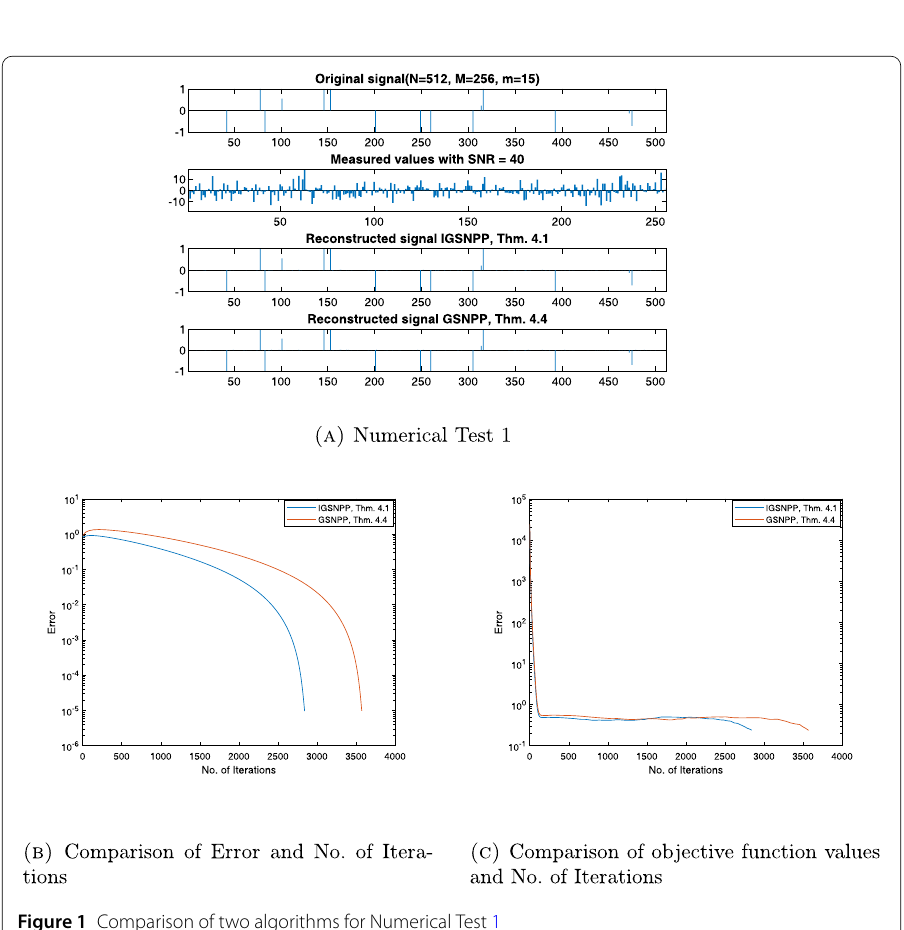
Figure 1 Comparison of two algorithms for Numerical Test